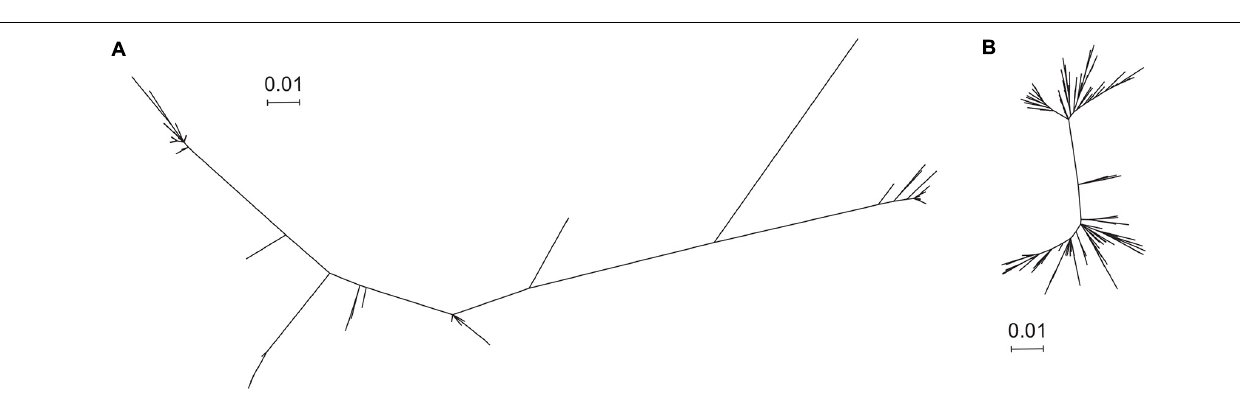
FIGURE 2 | Phylogenic tree of gB and the pentamer complexes. 207 HCMV strains containing both gB and the proteins composing the pentamer were used for analysis. (A,B) Phylogenic analysis of the amino acid sequences by Maximum Likelihood method, bootstrapped 500 times, conducted by MEGA X. (A) gB tree and (B) pentamer complex